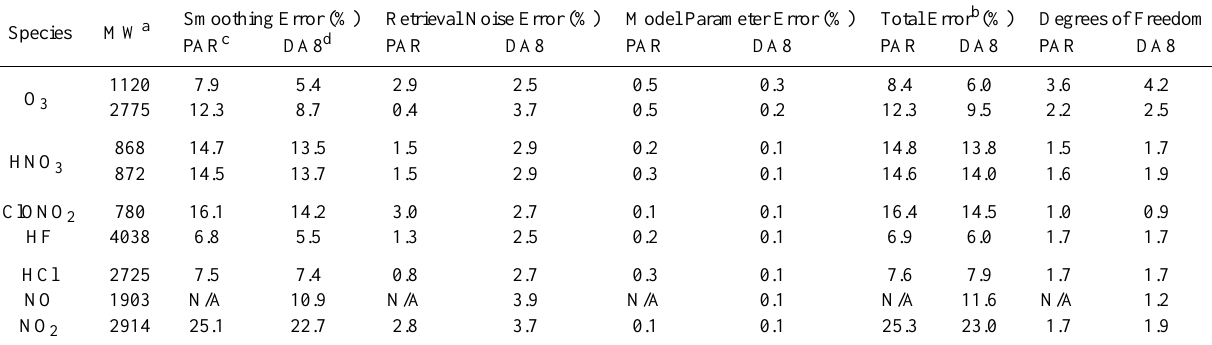
Table 2. Degrees of freedom for signal and uncertainties in the retrievals of total vertical column densities obtained from measurements by the DA8 FTS and PARIS-IR. Smoothing Error (%) Retrieval Noise Error (%) Model Parameter Error (%) Total Error b (%) Degrees of Freedom Species MW a PAR c